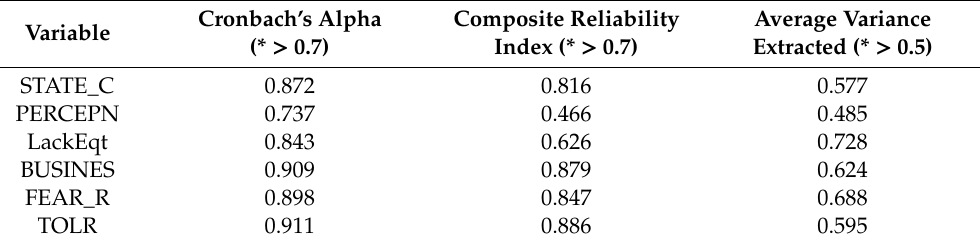
Table 2. Reliability measurement.